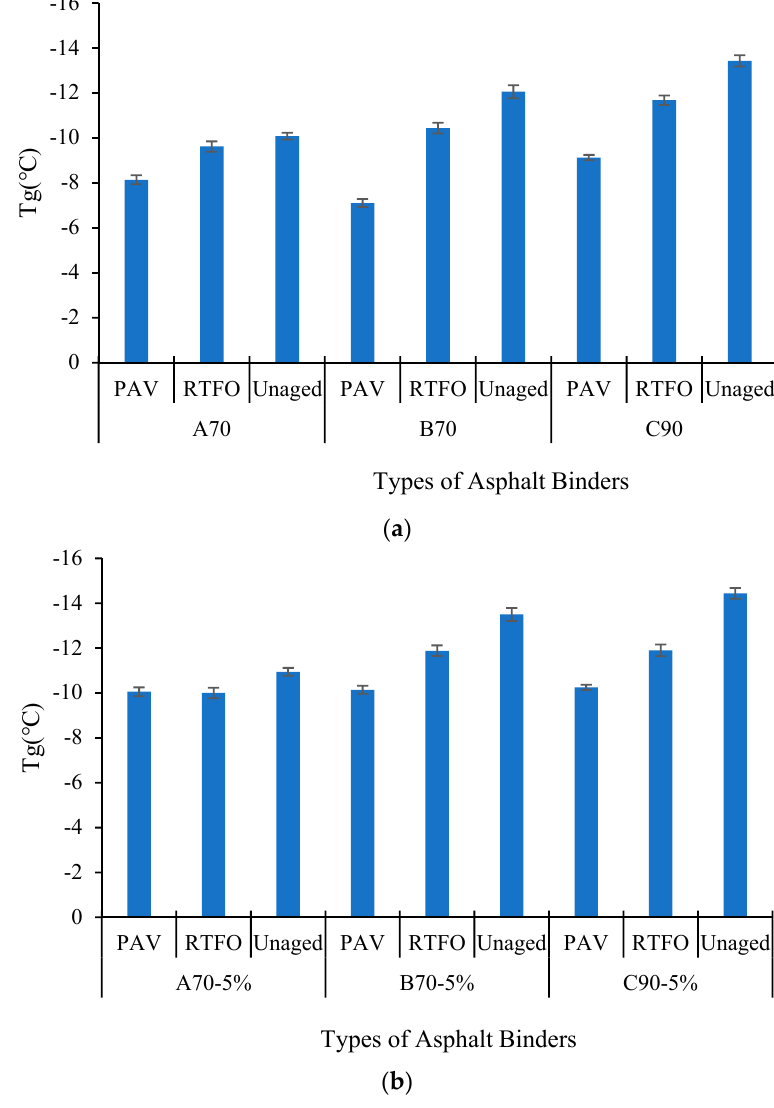
Figure 8. The T g of binders at different aging states ( a ) base binder ( b ) SBS modified binder. The glass transition temperatures of the three asphalt sources, with the addition of 5% SBS for different aging states, are shown Figure 8. The glass transition temperature of the modified asphalt in unaged, RTFO and PAV state rose with the increase in aging degree. At the same time, for the same source of asphalt in the B70 and C90 binders, the glass transition temperature at the same degree of aging decreased with the increase in grade.